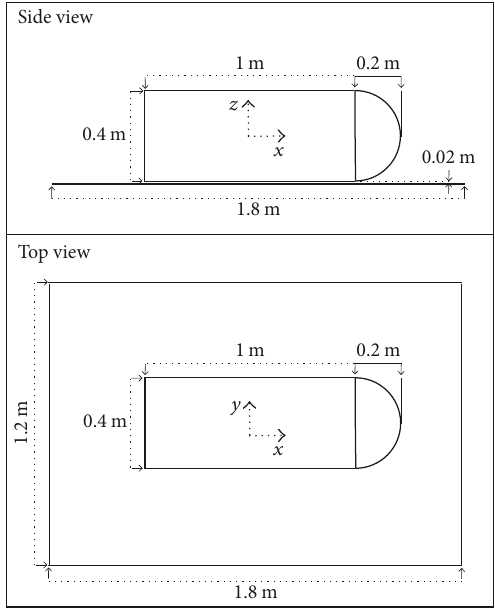
Figure 2: Geometrical model of the PLACYL case.